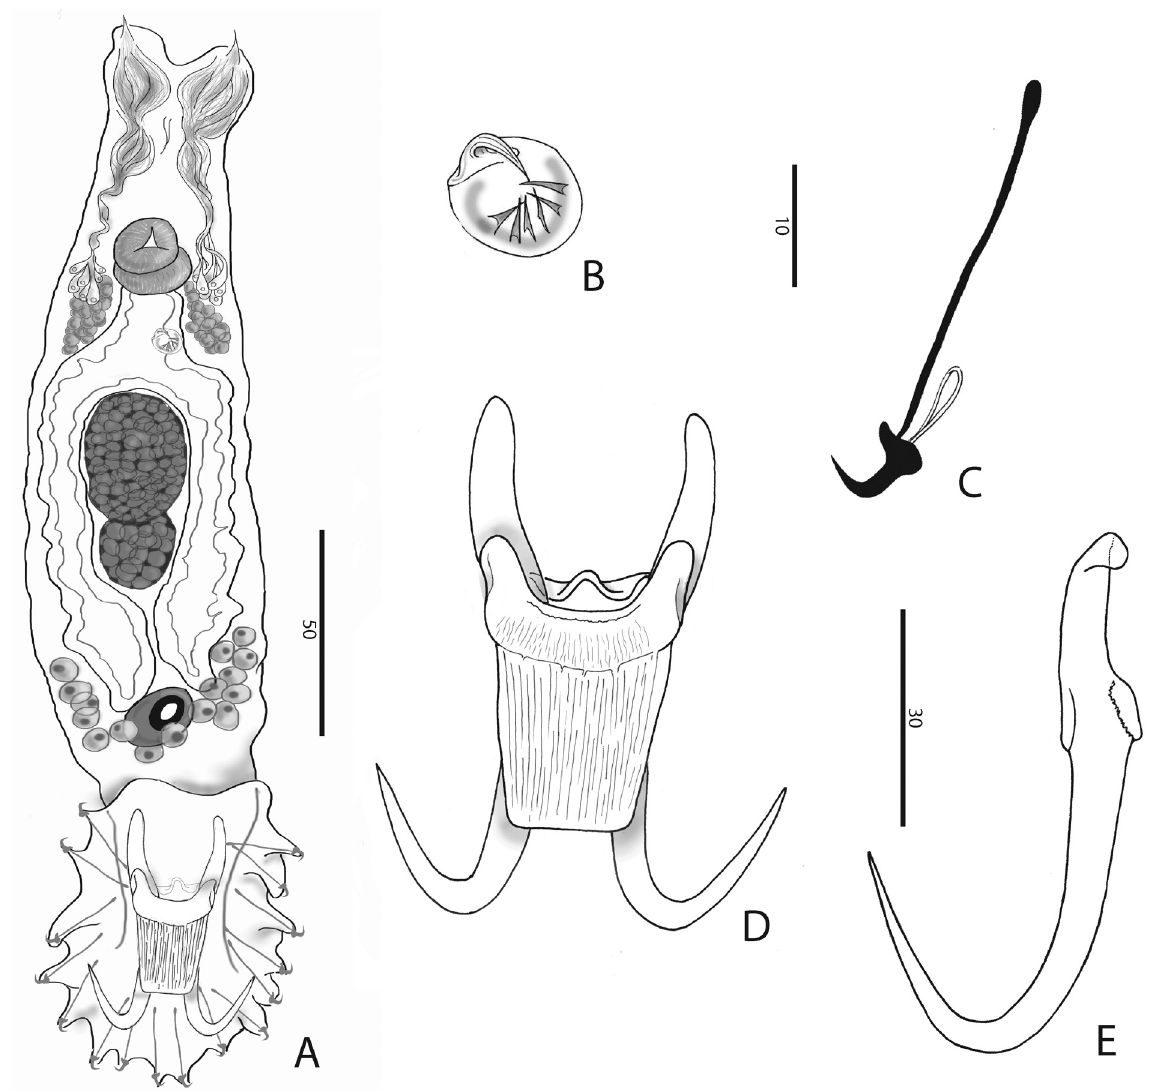
Fig. 1. Gyrodactylus jalalii sp. nov. A . whole mount. B . male copulatory organ. C . marginal hook. D . anchor-bar complex. E . anchor. Scale bars represent 50 µm (whole mount), 10 µm (marginal hook, MCO) or 30 µm (anchor,